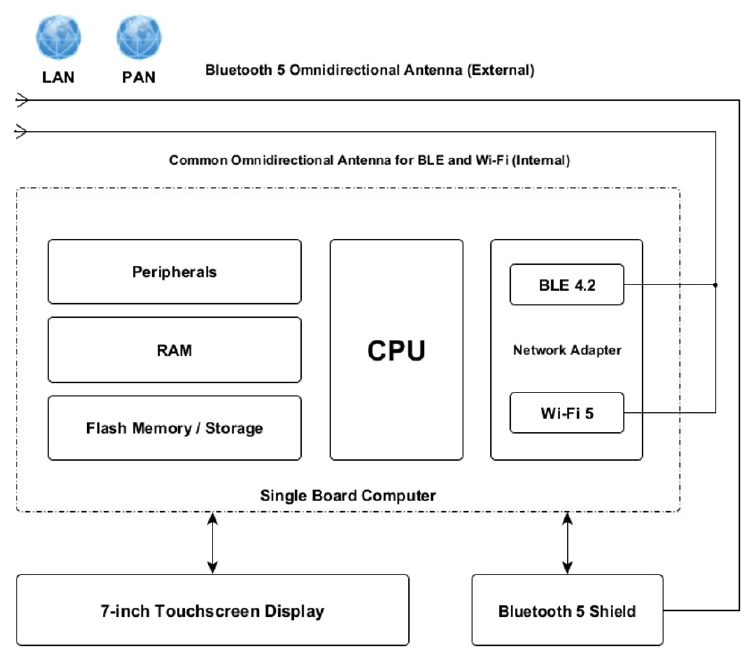
Figure 4. Block diagram of the central control and calculation unit.